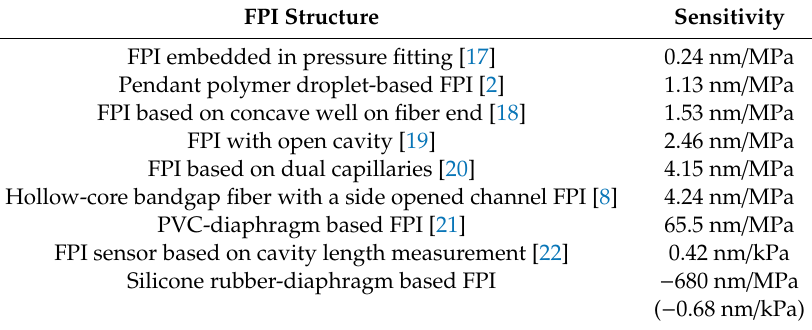
Table 1. Gas-pressure sensitivities of several fiber-optic FPI sensors.